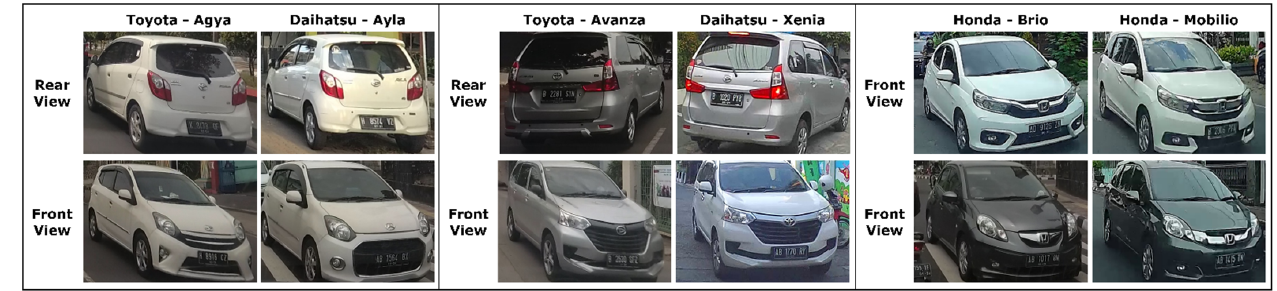
Figure 1. A pair of vehicle model images that are highly similar.